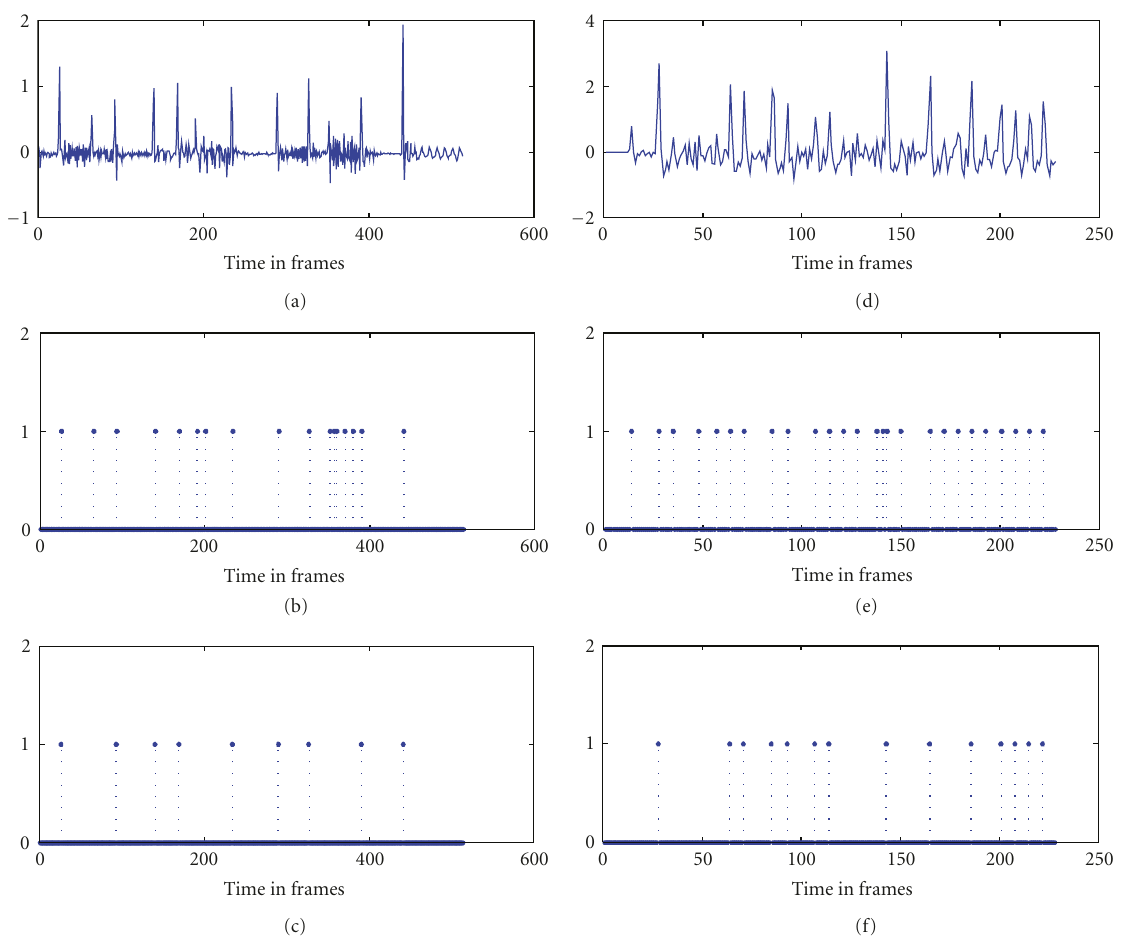
Figure 18: Adjusting the threshold used for localisation of the onsets can improve the robustness against the instrumental dynamics. In this example, two di ff erent values of the threshold, that is, 0.1 (corresponding to subplots (b) and (e)) and 0.3 (corresponding to subplots (c) and (f)) were used for onset detection of the piano and guitar signals, whose detection functions h o Subplots (b) and (c) show the locations of the onsets detected using the relative di ff erence functions with the threshold set to 0.1 and 0.4, respectively, for the piano signal, and (e) and (f) for the guitar